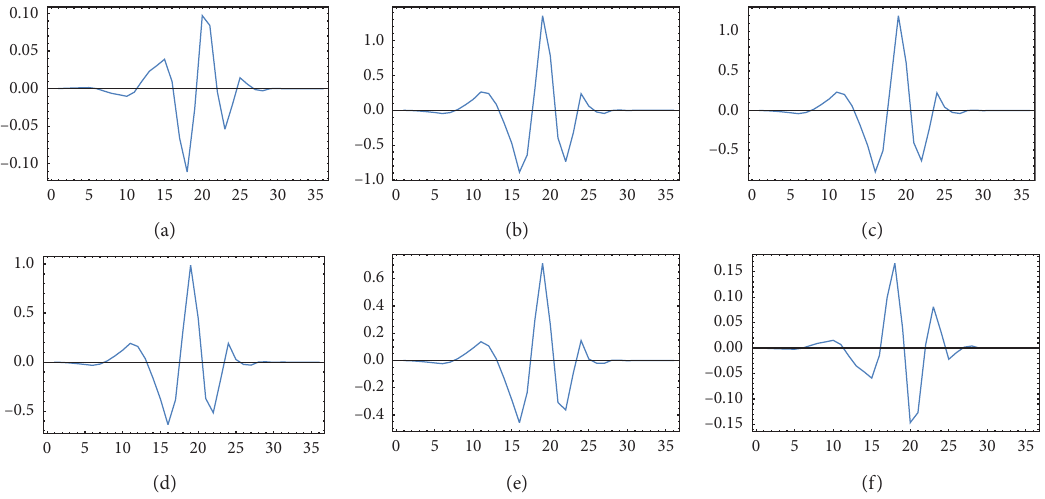
Figure 1: HTof Daubechies wavelet and FRBTs of Daubechies wavelet at θ � 0 , π /6 , π /4 , π /3 , π /2. (a) HTof Daubechies wavelet. (b) FRBTof Daubechies wavelet with θ � 0. (c) FRBT of Daubechies wavelet with θ � π /6. (d) FRBT of Daubechies wavelet with θ � π /4. (e) FRBT of Daubechies wavelet with θ � π /3. (f) FRBT of Daubechies wavelet with θ � π /2.